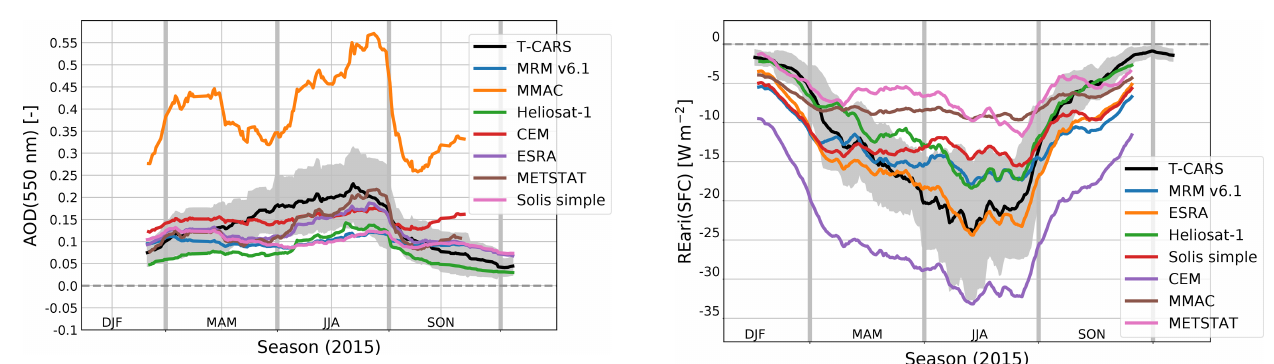
Figure 7. Annual overview of average scaled AOD at 550nm over all DWD measurement stations from CSF with different CSM com- pared to T–CARS. AOD values are shown as a 30d rolling mean. For T–CARS the 30d standard deviation is shown as a grey area. Table 8. Comparison of the annual mean of daily average AOD values, scaled to 550nm. The values are averaged over all DWD stations and derived from CSF with different CSM. The reference AOD is calculated with T–CARS. Model